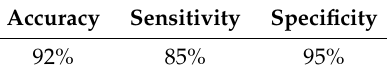
Table 4. CNN results for experiment number 3 in terms of Accuracy, Sensitivity and Specificity. The metrics are evaluated on the Azores dataset (never shown during the training). The predictions have been robustly computed considering that an unknown image is classified as fin or no-fin only if 4 CNNs out of 5 give the same